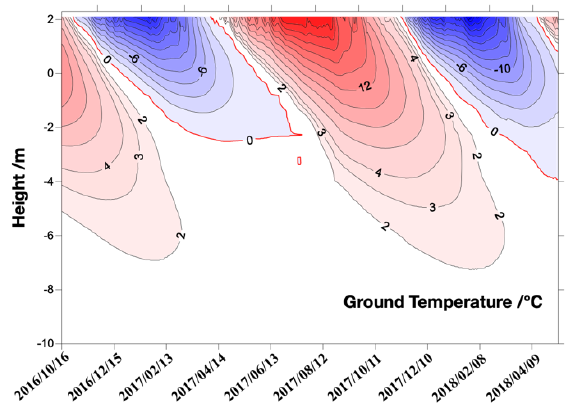
Figure 4. Subgrade freeze-thaw cycle revealed by temperature monitoring data